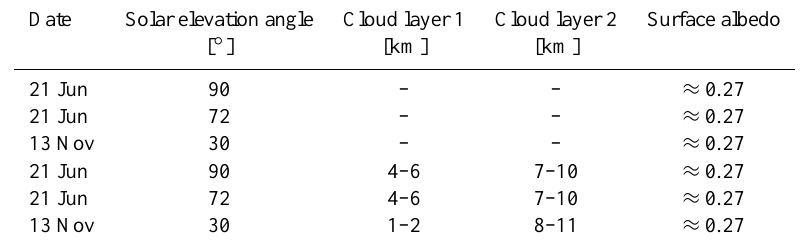
Table 1. Settings for simulations with the Streamer model.